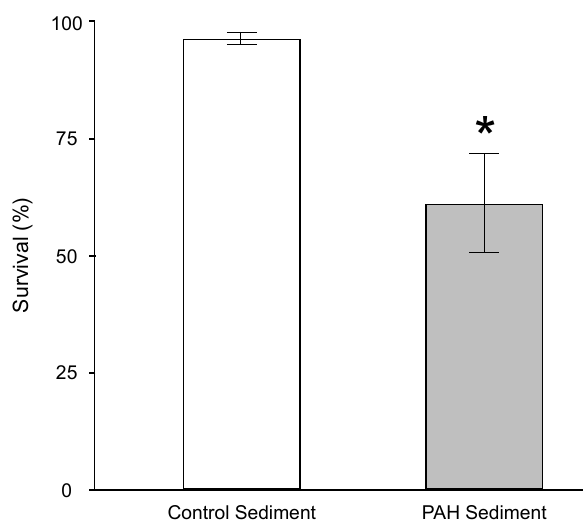
Figure 2. Mean nymph survival with standard error, grouped by sediment treatment. Survival was significantly lower in the PAH-spiked sediment treatment group in comparison to the control sediment treatment group (denoted by “*”).